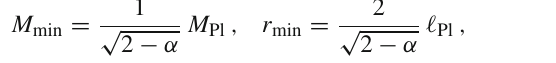
Fig. 2 a Temperature implied by surface gravity argument as a func- tion of mass in ‘ M + 1 / M ’ model for β = 1 (red, bottom), β = 0 . 5 (blue, middle) and β = 0 . 1 (green, top). The temperature reaches a maximum and then decreases, so that the black hole cools to a config-